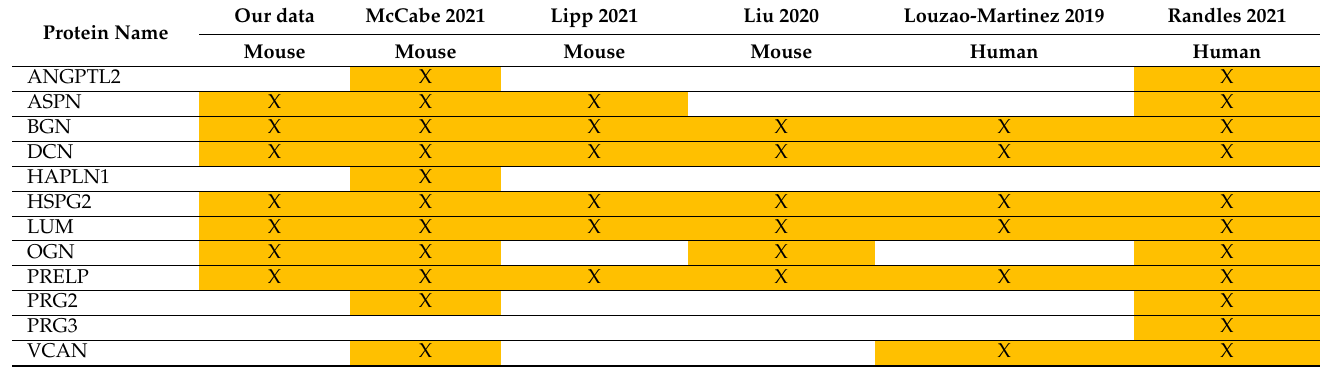
Table A12. The combined list of core matrisome proteins belonging to the category of proteoglycans and identified in mouse and human kidneys. The mouse matrisome proteins were obtained from our data and extracted from references [20,28,30]. Human matrisome proteins were obtained from the studies [31,32]. Highlighted “X” refers to identified protein in the corresponding study.